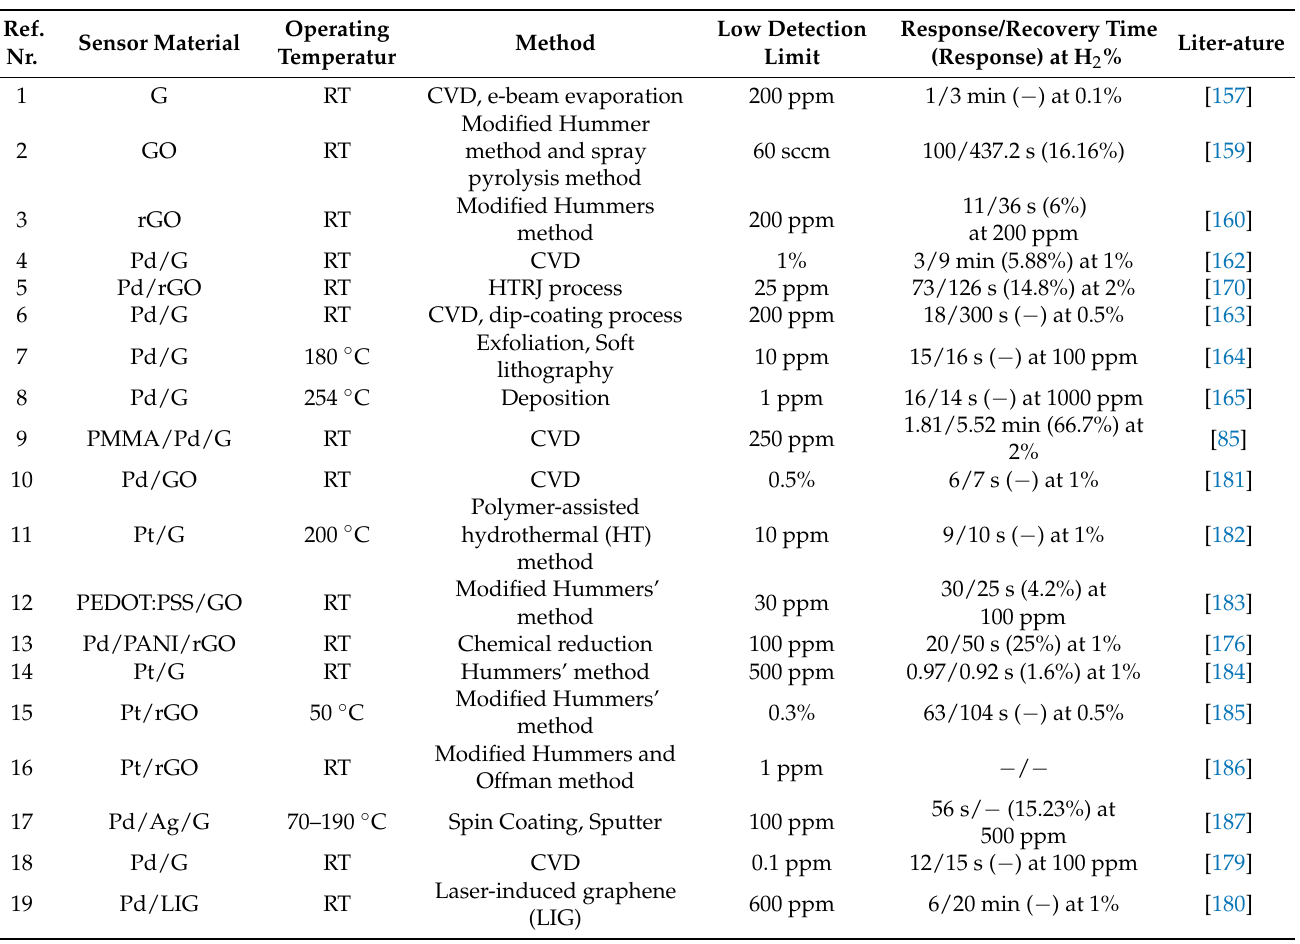
Table 3. Comparison of sensing performances towards hydrogen gas of the transition metal/graphene (e.g., GO, rGO)-based gas sensors in literature. Unless specified, the sensor response is defined by Equation (1). RT: room temperature, CVD: chemical vapour deposition, HTRJ: high-temperature reducing jet.